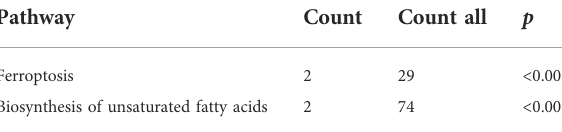
Ferroptosis 2 29 <